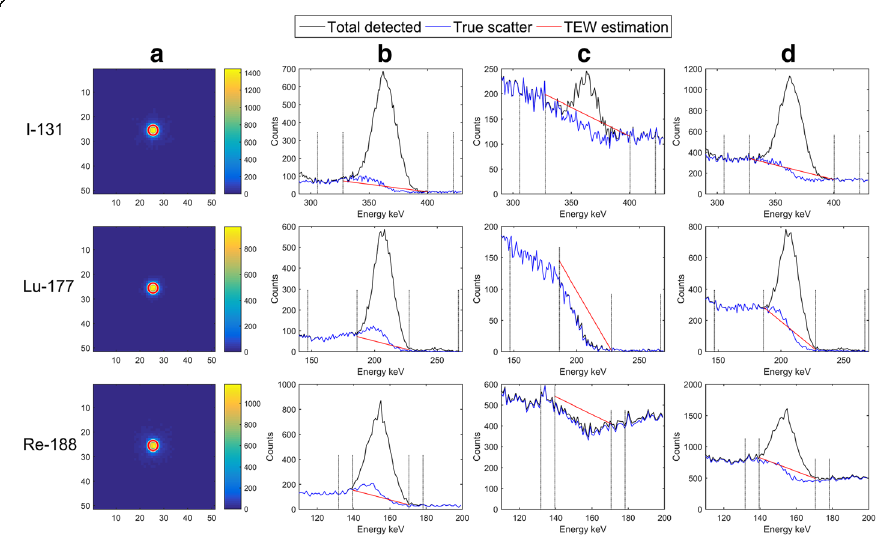
Fig. 5 The energy spectra obtained from the simulations of the phantom scanned in configuration B (HS + CB). The counts recorded in the photopeak window and correspond to the ROI drawn on the projection images: around the hot object (column b ), in the background surrounding this ROI (column c ), and in the entire image (column d ). Column a shows the simulated PW projections. The hot object ROI was placed inside the red circle while the background ROI comprised all counts found on the outside of the red